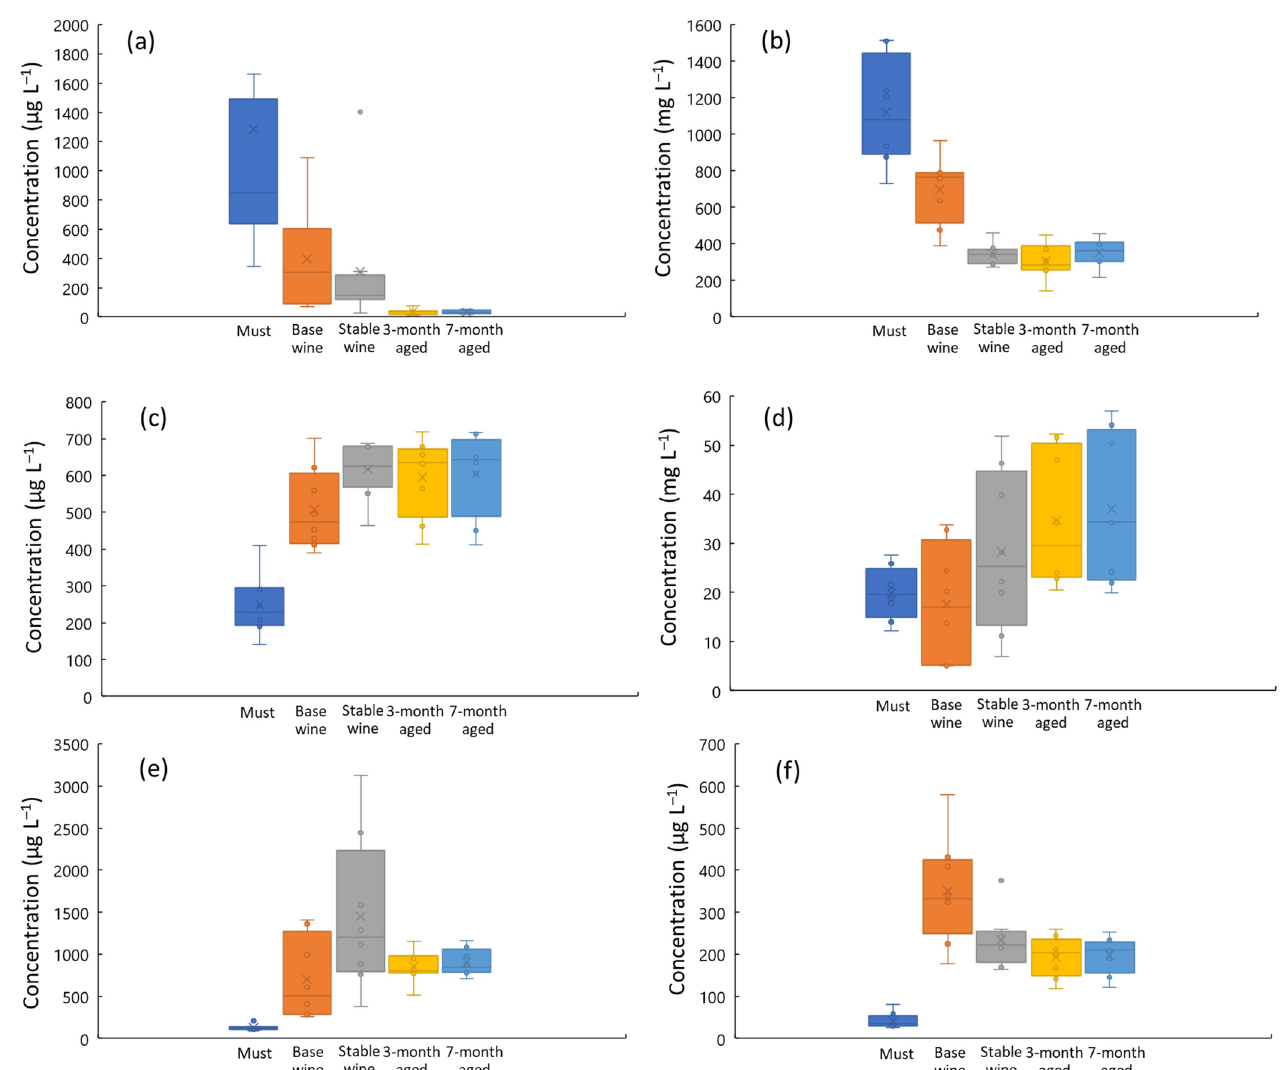
Figure 1. Boxplot diagrams with the concentrations of Cu ( a ), K ( b ), Mn ( c ), Na ( d ), Al ( e ), and S ( f ), for the different type of samples.